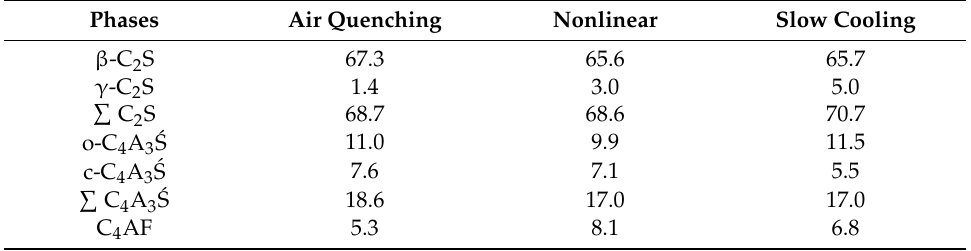
Table 3. The phase composition of the clinkers as determined using the Rietveld method